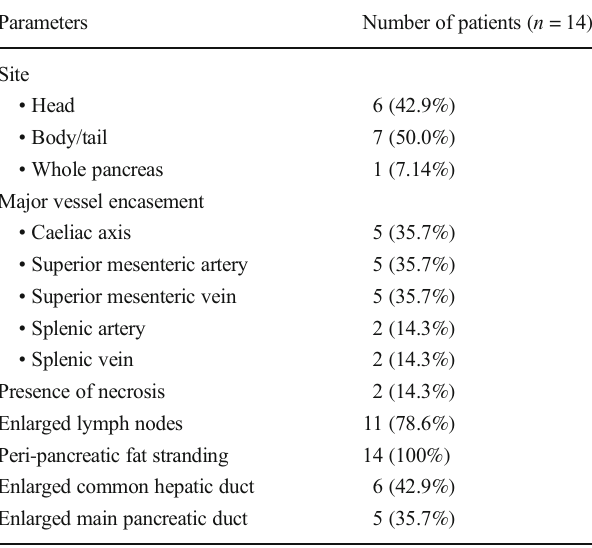
Fig. 2 A 62-year-old male patient with primary pancreatic lymphoma, histotype high-grade B-cell lymphoma not otherwise specified (Ki 67 score > 90%). a CT scan of the abdomen shows the presence of a solid mass in the pancreatic head (arrow). b, c, d CT images after contrast medium administration in the arterial-pancreatic phase ( a ) and portal-